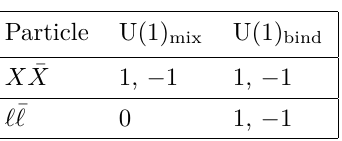
Table 1. The field content of the dark sector with the U(1) charges at tree